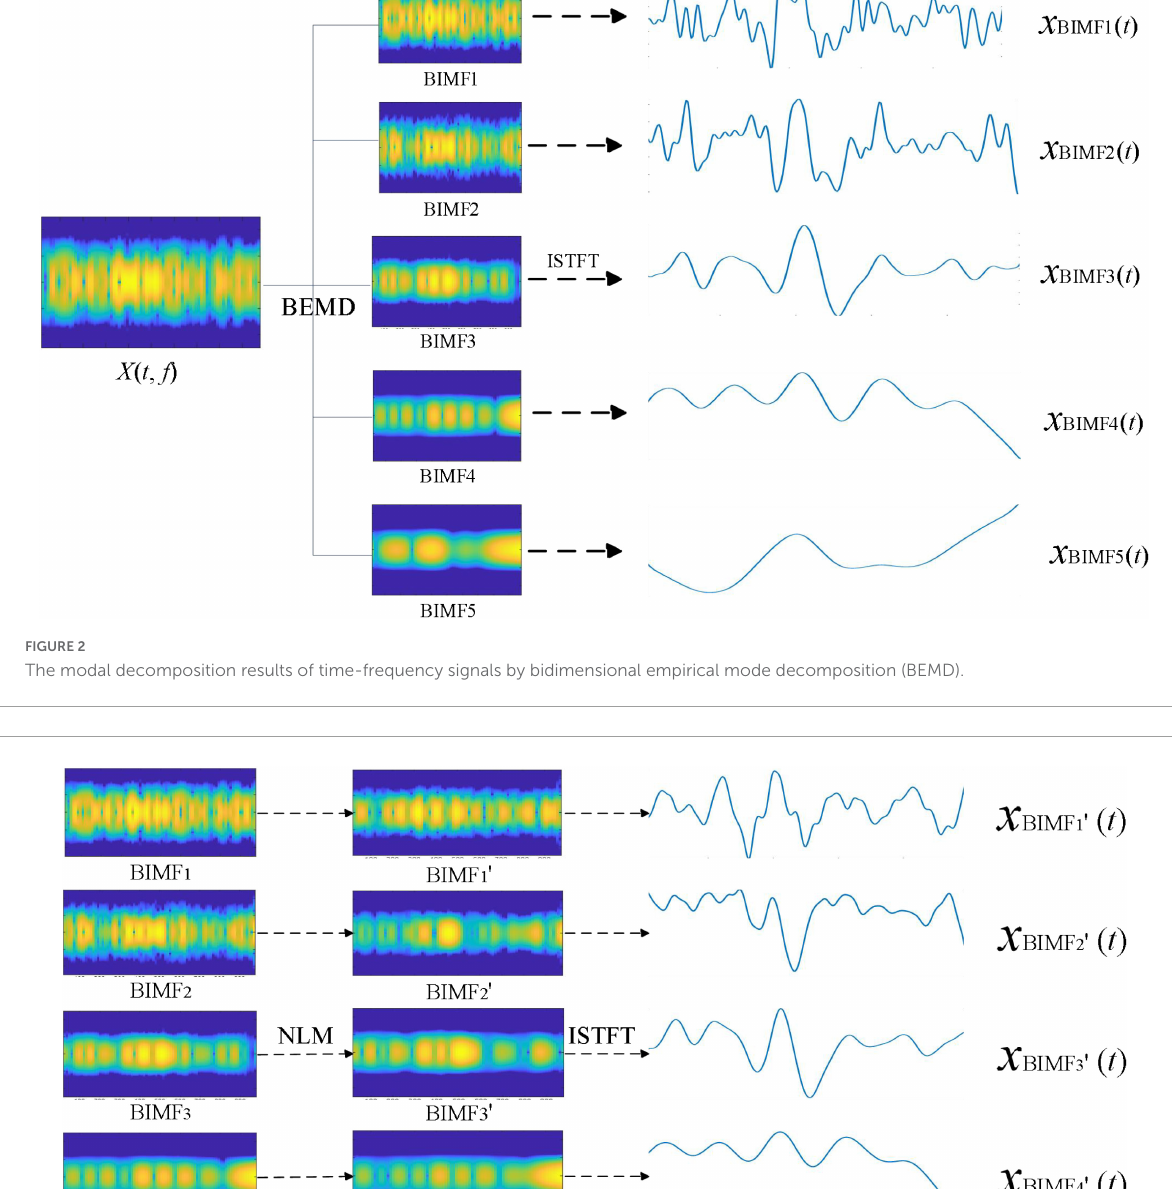
original signal waveform and differed greatly from the reference signal. The signal processed by EEMD-ICA was also quite different from the reference signal. The signal processed by